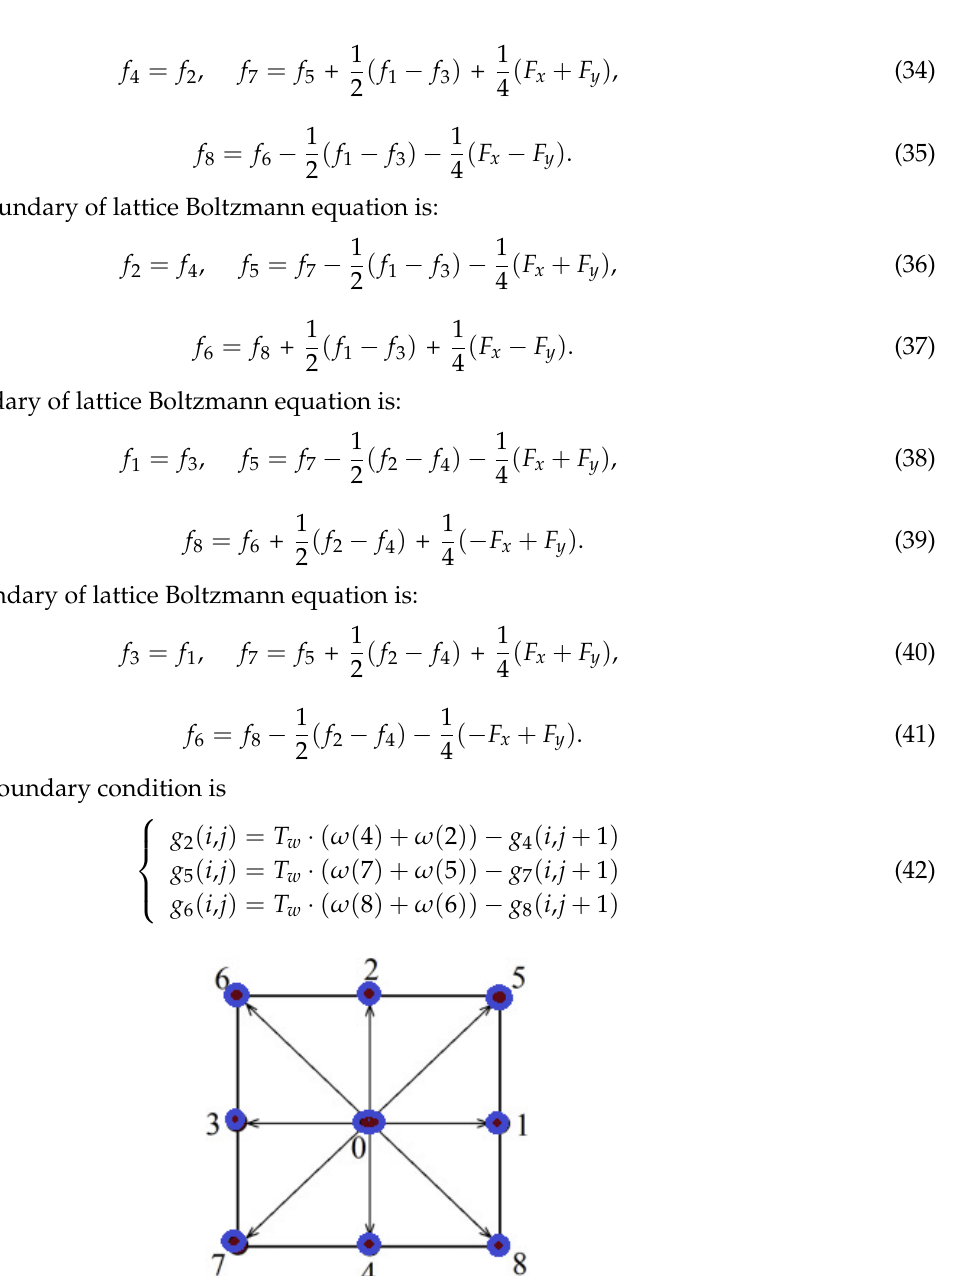
Figure 2. LBM 2D